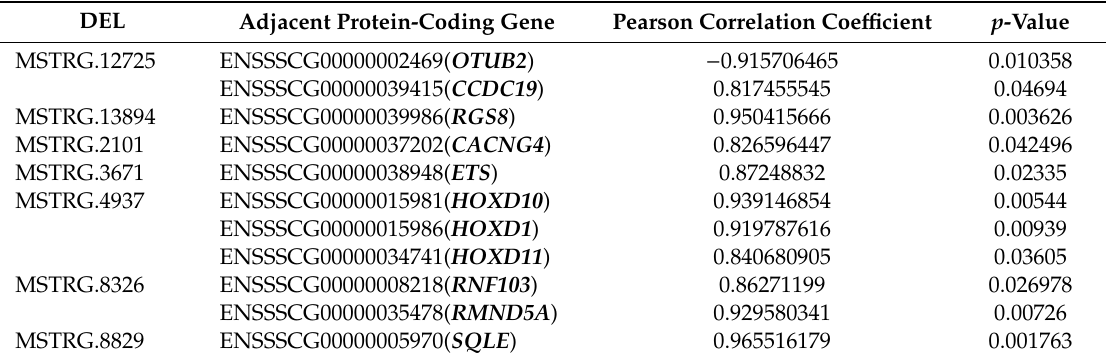
Table 2. The correlation between DEL and its neighboring protein-coding genes.